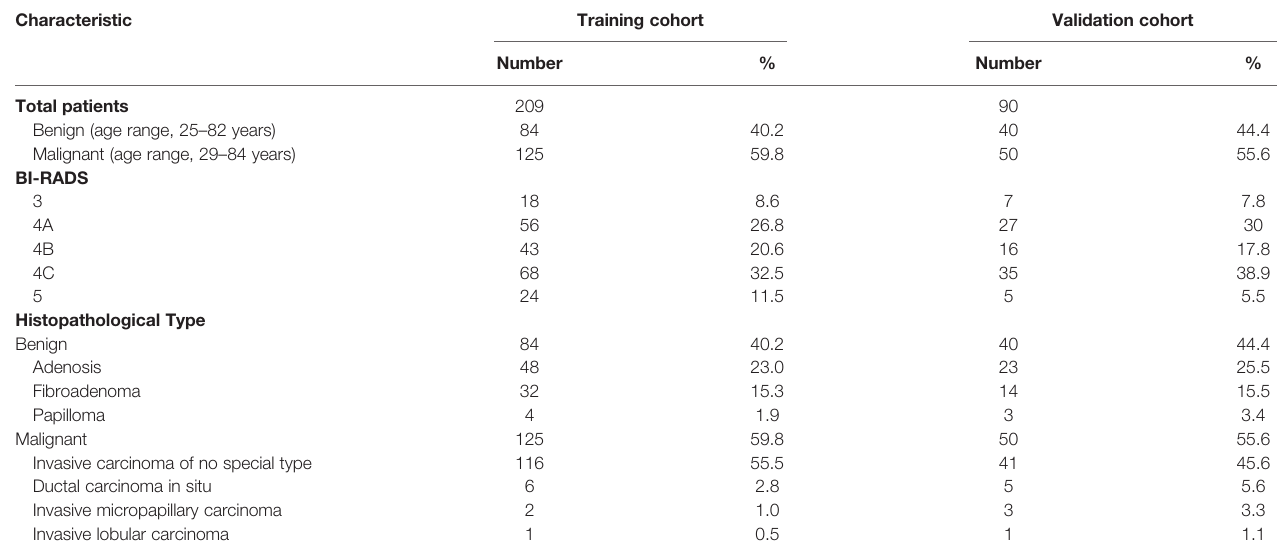
TABLE 1 | Clinical characteristics of the patients selected for this study.